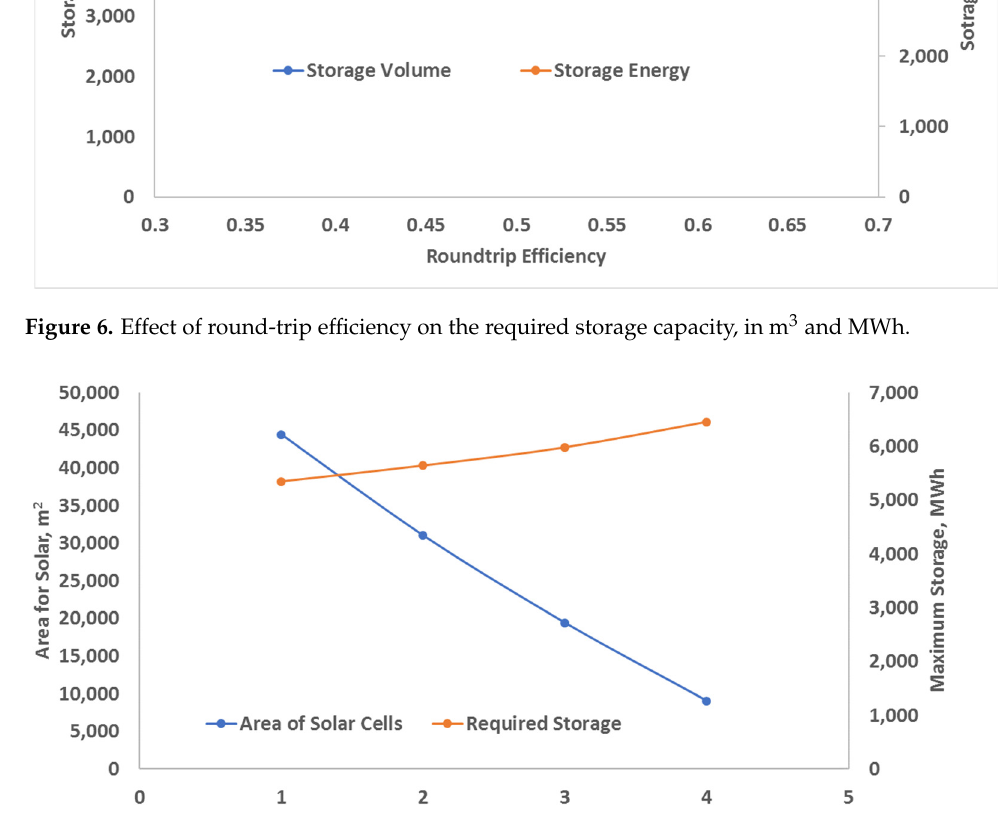
Figure 6. Effect of round-trip efficiency on the required storage capacity, in m 3 and MWh.